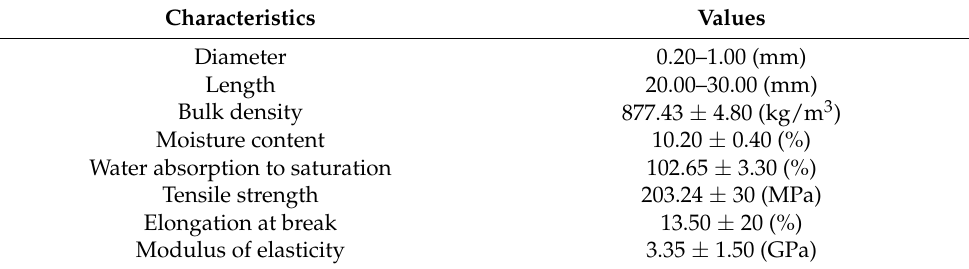
Table 2. Physical and mechanical characteristics of